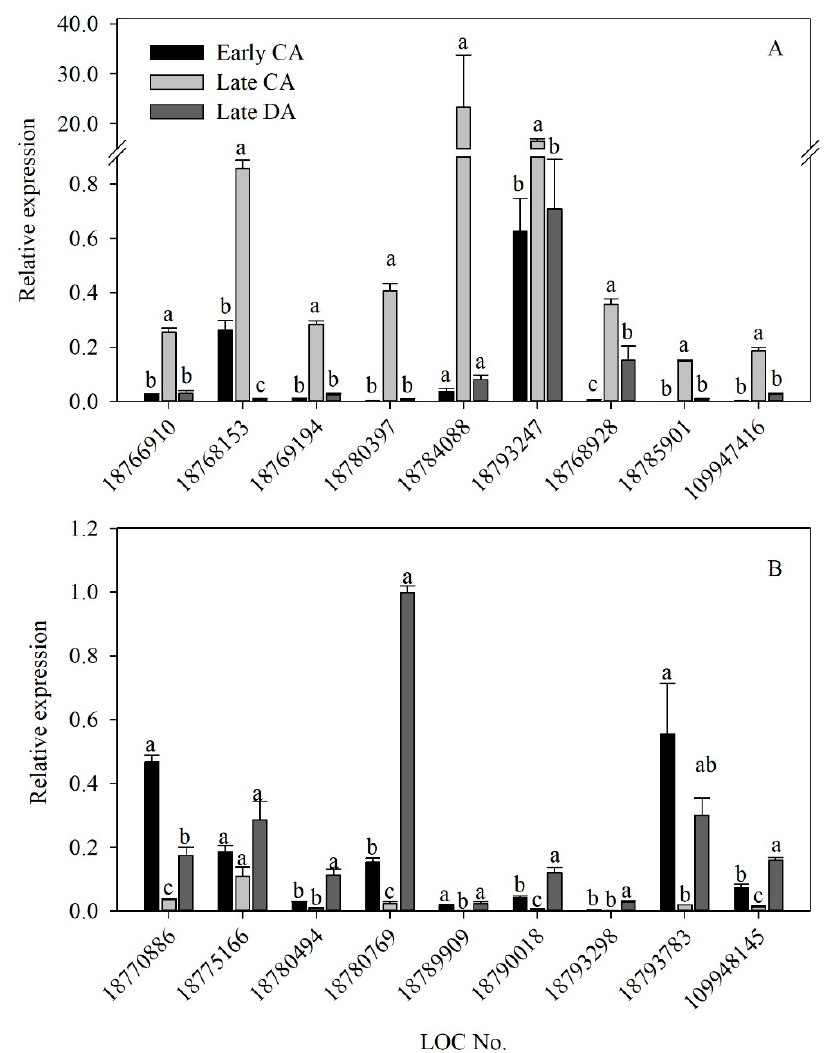
Figure 5. Relative gene expressions for the validation of ( A ) the selected nine DEGs up- and down-regulated during cold acclimation (CA), from early to late CA, and deacclimation (DA), from late CA to late DA, respectively, and ( B ) the selected nine DEGs down- and up-regulated during CA, from early to late CA, and DA, from late CA to late DA, respectively, in the ‘Soomee’ peach tree shoots. The DEGs were selected based on the significance of fold change during CA and DA. Vertical bars are the standard errors of the means ( n = 3). Different letters indicate significant differences among the three physiological stages within the same DEGs using the Duncan’s multiple range test at p < 0.05. LOC18766910, non-symbiotic hemoglobin ; LOC18768153, squalene monooxygenase ; LOC18769194, polygalacturonase inhibitor ; LOC18780397, tonoplast dicarboxylate transporter ; LOC18784088, late embryogenesis abundant protein 2 ; LOC18793247, extracellular ribonuclease LE ; LOC18768928, bidirectional sugar transporter SWEET1 ; LOC18785901, 14 kDa proline-rich protein DC2.15 ; LOC109947416, pEARLI1-like lipid-transfer protein 3 ; LOC18770886, O-acyltransferase WSD1 ; LOC18775166, phosphoenolpyruvate carboxykinase ( ATP ); LOC18780494, protein SRG1 ; LOC18780769, protein E6 ; LOC18789909, non-specific lipid-transfer protein 2 ; LOC18790018, aspartyl protease AED3 ; LOC18793298, cyclin-D1-1 ; LOC18793783, heterogeneous nuclear ribonucleoprotein A2 homolog 1 ; LOC109948145, vinorine synthase-like